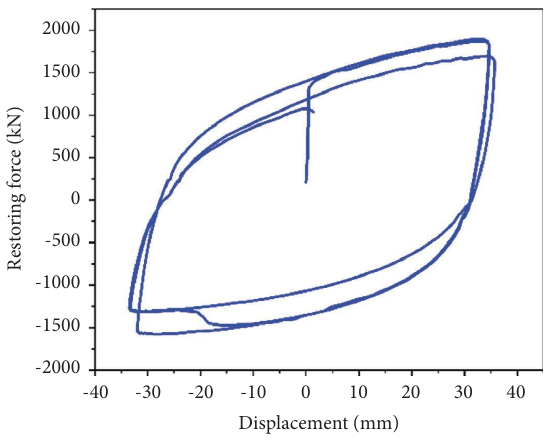
Figure 6: Experimental hysteresis